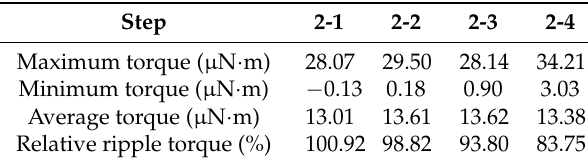
Table 3. Step 2: Comparison table of the torque characteristic of each step.